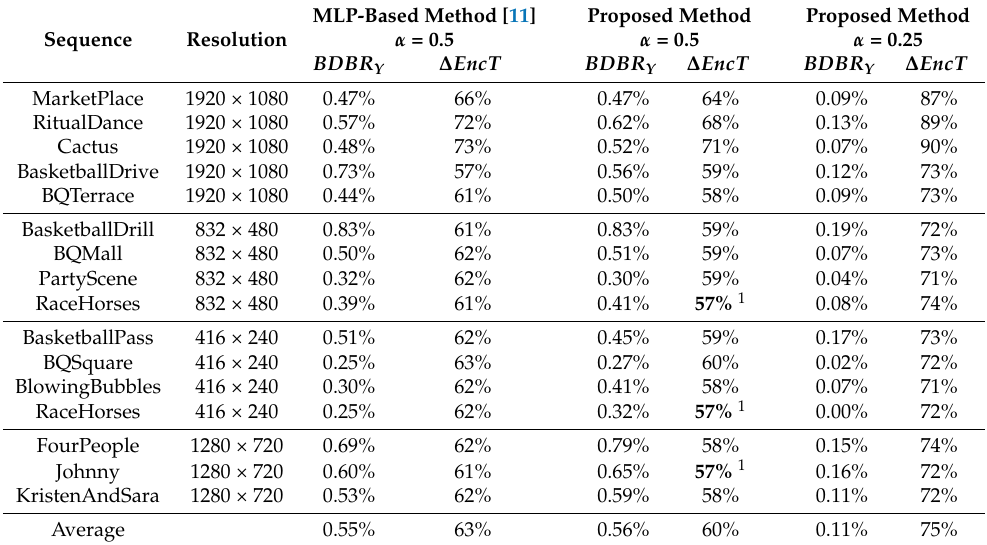
Table 8. Comparison of the existing and proposed methods relative to the anchor (VTM 4.0).